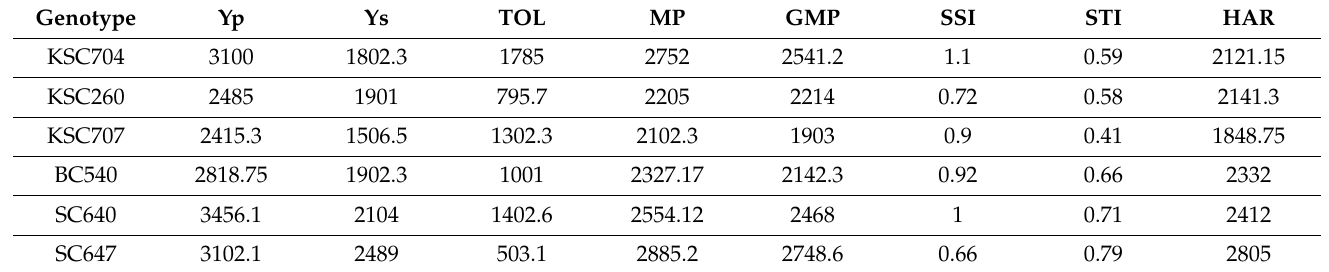
Table 4. Values of water-stress-tolerance indices for maize genotypes under stress conditions on ear.